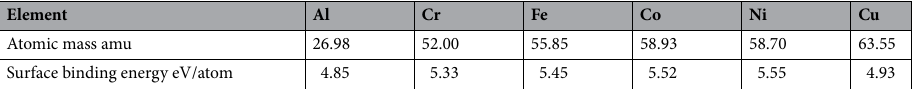
Table 3. Atomic mass and surface binding energy of each element in an AlCrFeCoNiCu0.5 HEA thin film.